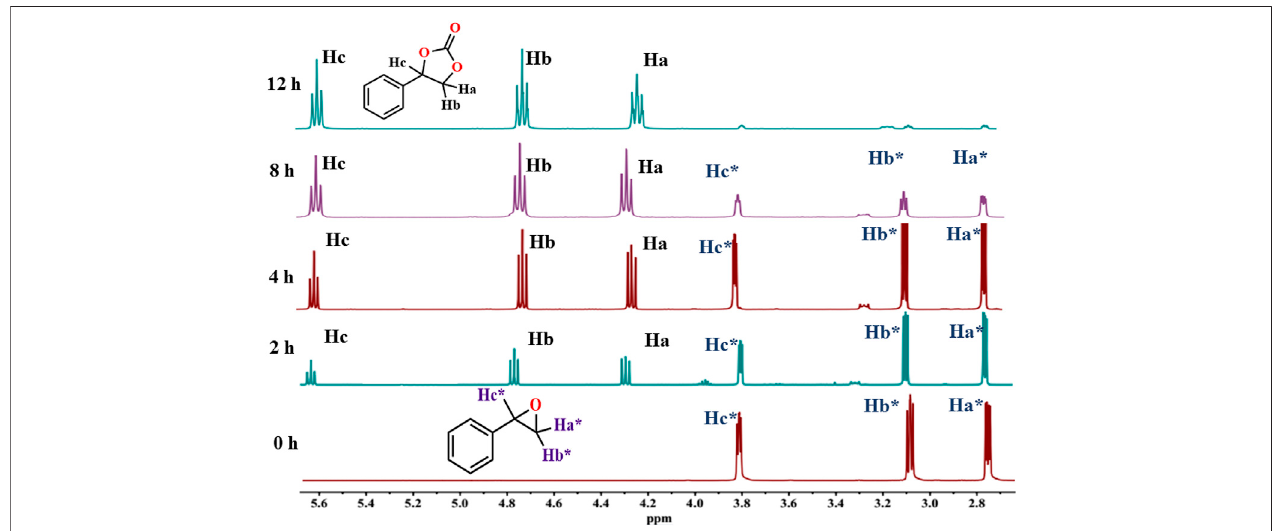
FIGURE 6 | Time-dependent 1 H CDCl 3 , 400 MHz NMR stack plot for the cycloaddition of CO 2 with styrene oxide catalyzed by HMP-TAPA showing gradual increase of peaks at 4.3, 4.8, and 5.6 ppm corresponds to the product, and decrease in the intensity of peaks around 2.7, 3.1, and 3.8 ppm corresponds to styrene